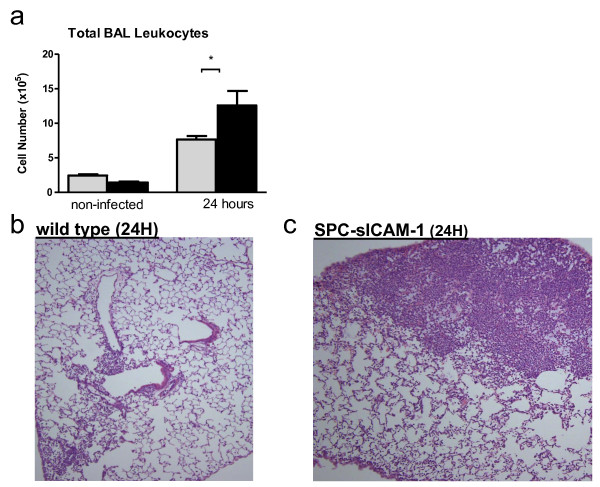
Increased pulmonary inflammation is observed at 24 hours after K. pneumoniae infection in SPC-sICAM-1 mice compared to wild-type mice. SPC-sICAM-1 mice and wild-type mice were intranasally inoculated with 250 CFU of K. pneumoniae. After 24 hours, the animals were euthanized, and whole lung lavage was performed. Whole lung lavage was also collected from mice inoculated with PBS, but not exposed to K. pneumoniae, for comparison. Total number of cells was determined by counting with a hemacytometer (A). Representative histologic sections of lungs in wild type (B) and SPC-sICAM-1 mice (C) 24 hours after infection. Data are expressed as mean ± SEM. (n = 6 in all groups; * P < 0.05 compared with wild-type).